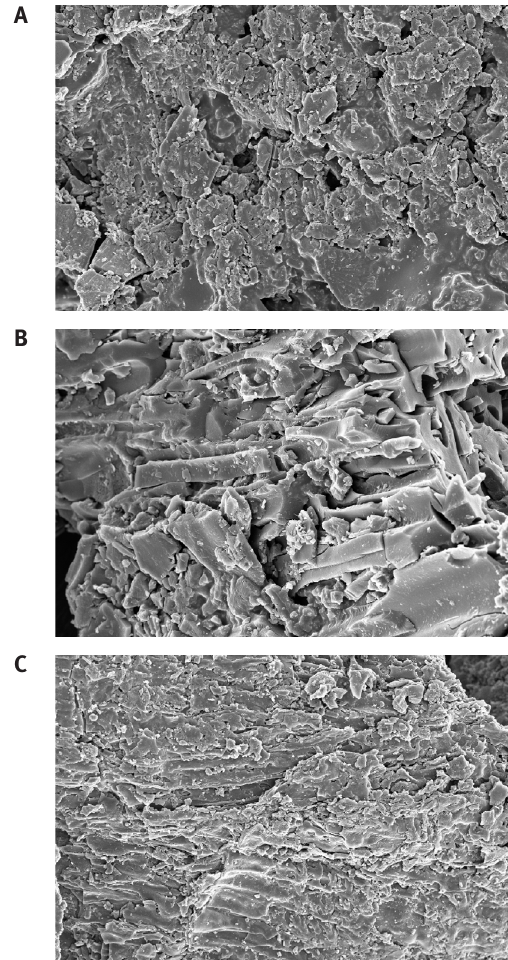
Figure 4: The predicted profile of higher I